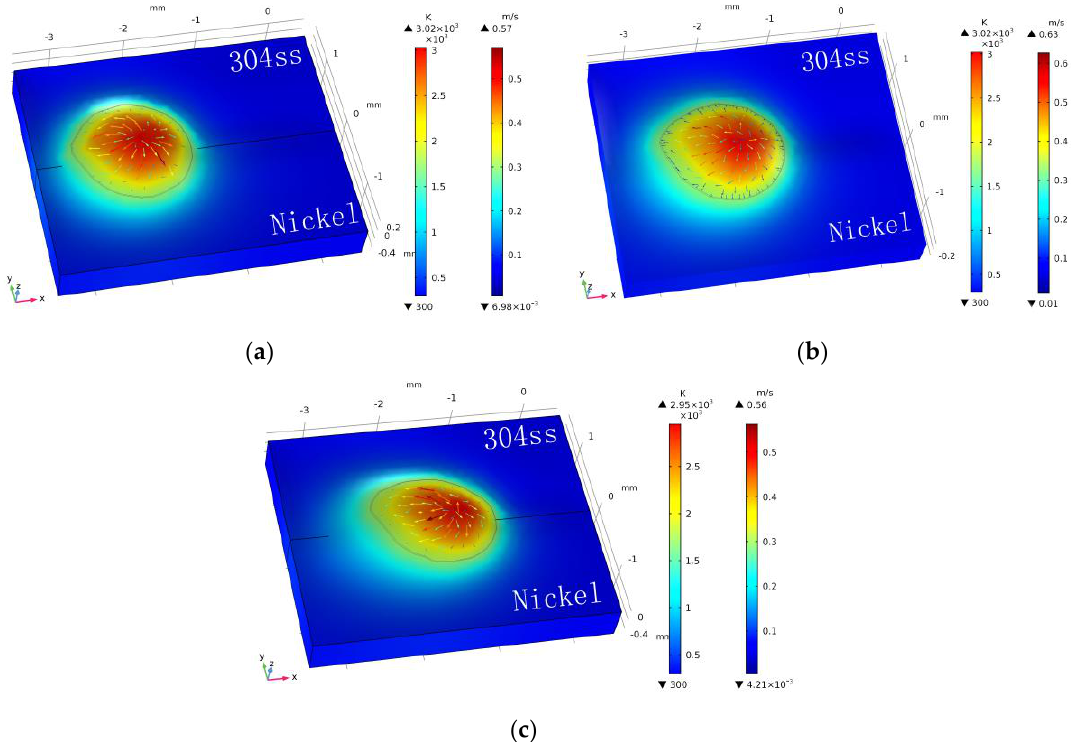
Figure 6. Temperature field and velocity distribution under different heat input. ( a ) 80 J/mm. ( b ) 40 J/mm. ( c ) 26.7 J/mm.